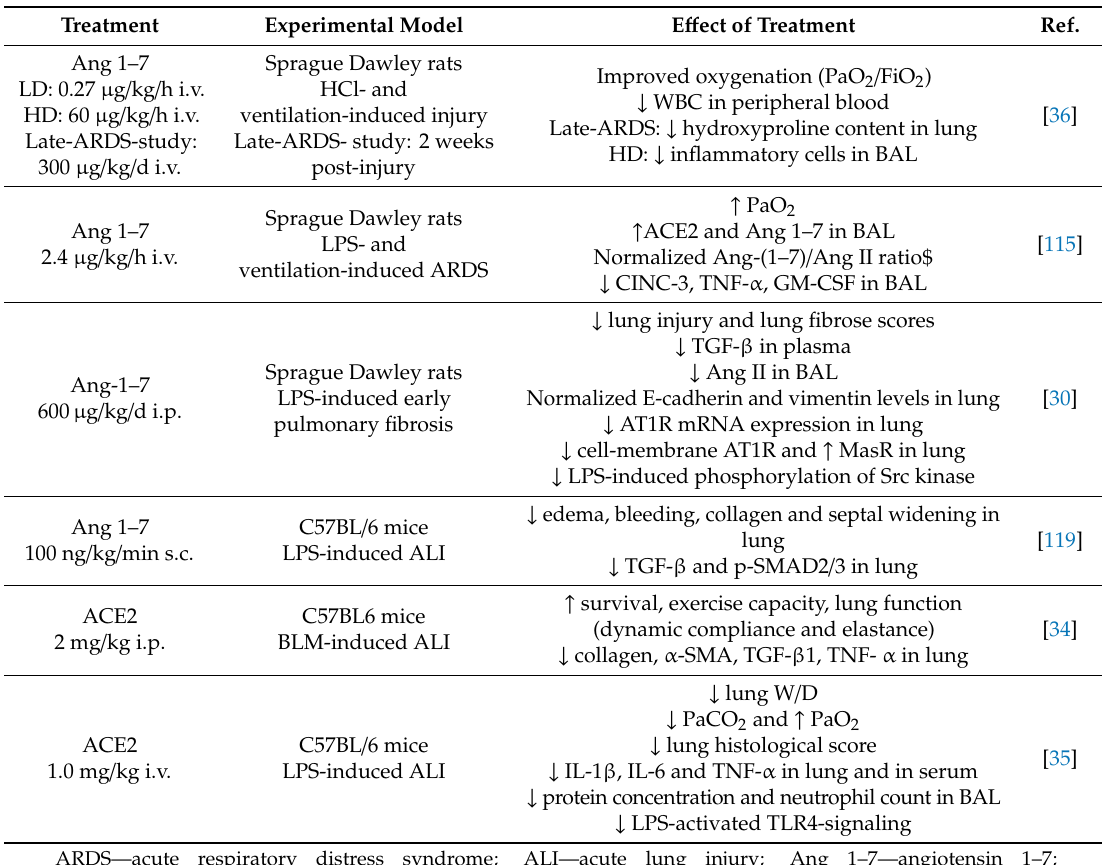
Table 2. E ff ect of angiotensin 1–7 and angiotensin-converting enzyme 2 in animal models of acute lung injury (ALI) / acute respiratory distress syndrome